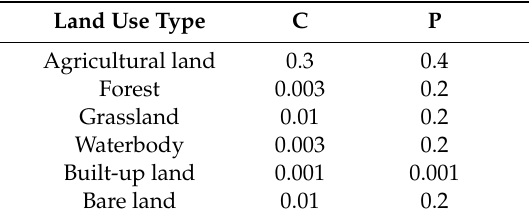
Table 2. Cover-management factor (C) and support practice factor (P)